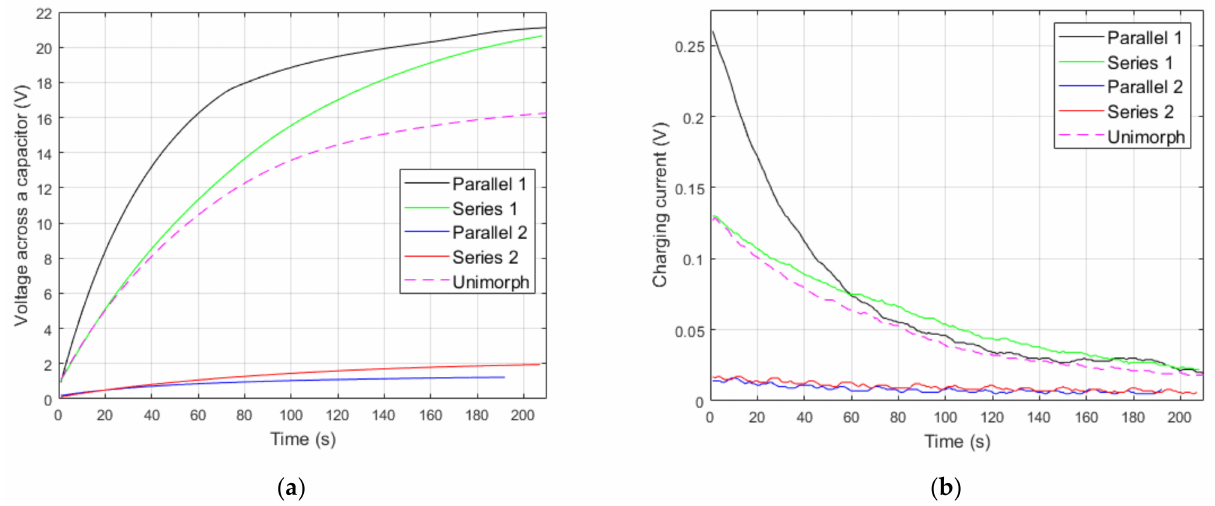
Figure 10. Capacitor charging by use of bimorph: ( a ) voltage across a capacitor; ( b ) average charging